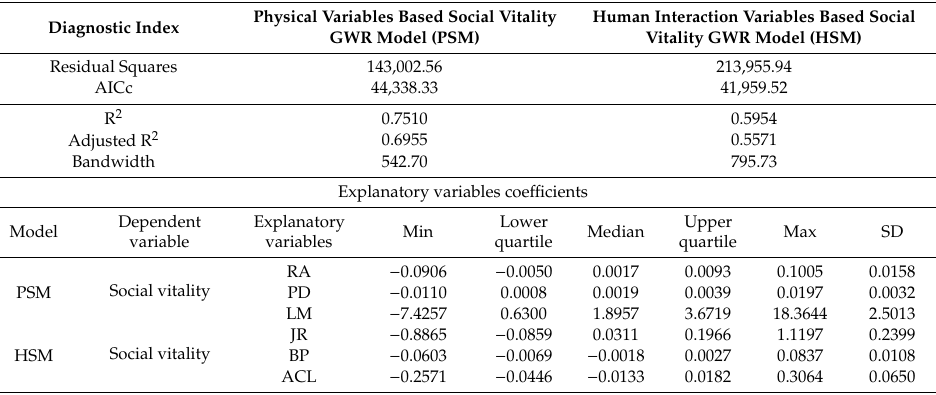
Table 7. GWR modeling results of social vitality and driving